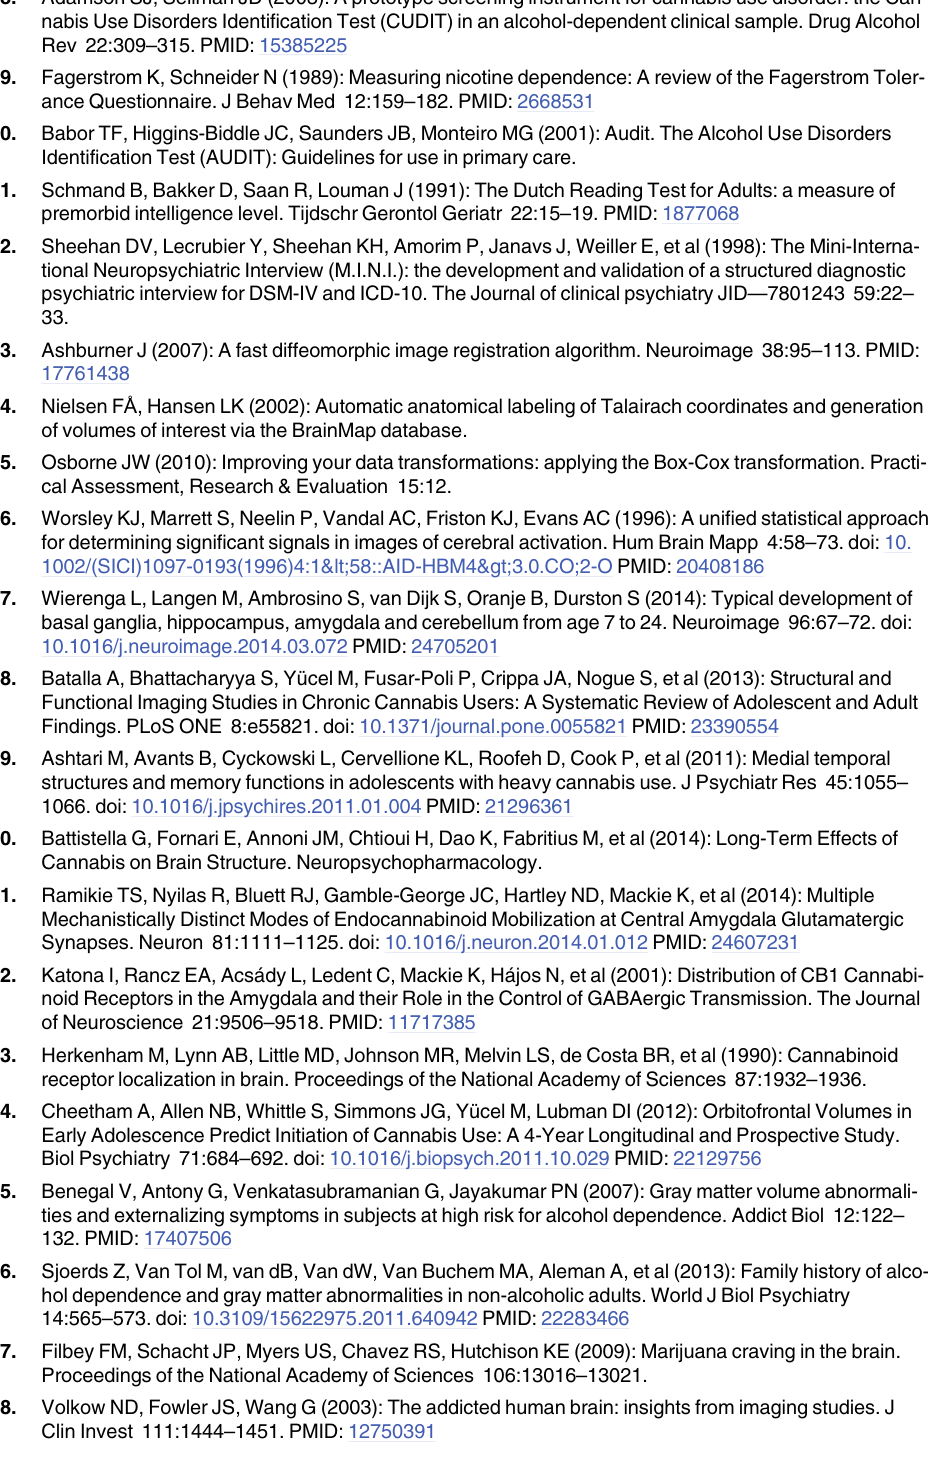
PLOS ONE | DOI:10.1371/journal.pone.0152482 May 25,